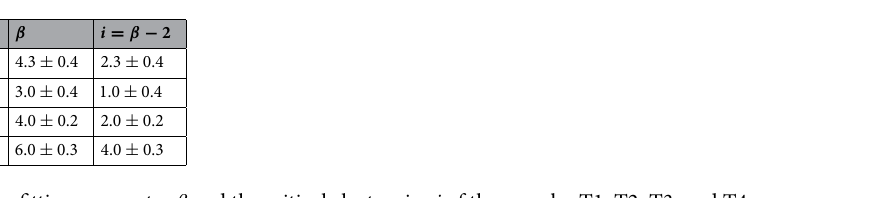
Table 2. The fitting parameter β and the critical cluster size i of the samples T1, T2, T3, and T4.